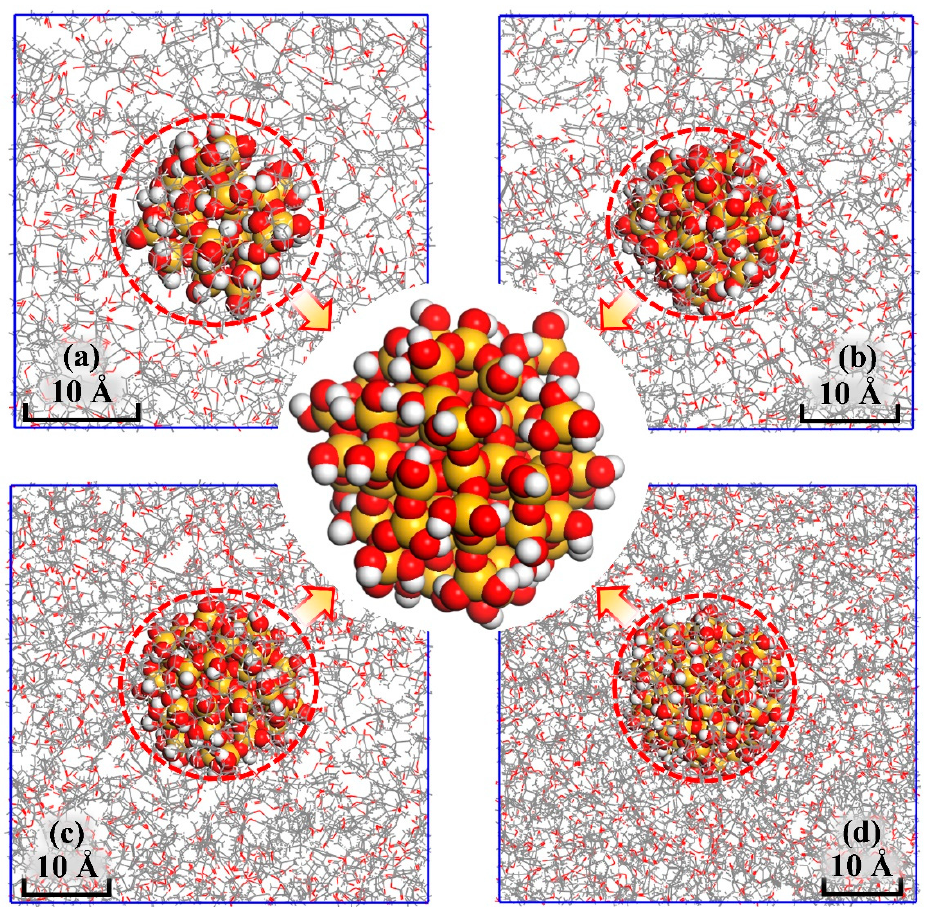
Figure 3. The crosslinked network in Epoxy Resin (EP) nanocomposite models. ( a ) For 6.5 Å; ( b ) for 7.6 Å; ( c ) for 8.8 Å; ( d ) for 10